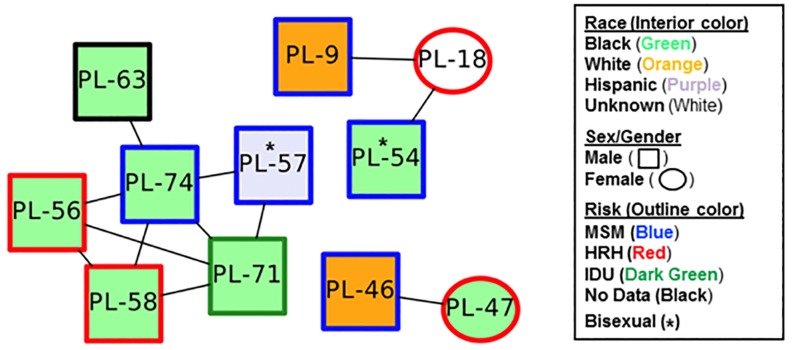
Transmission clusters were created using HIV-TRACE software based on RT NGS sequences generated using the ≥20% frequency cutoff along with participants’ race, sex/gender and HIV risk categories.